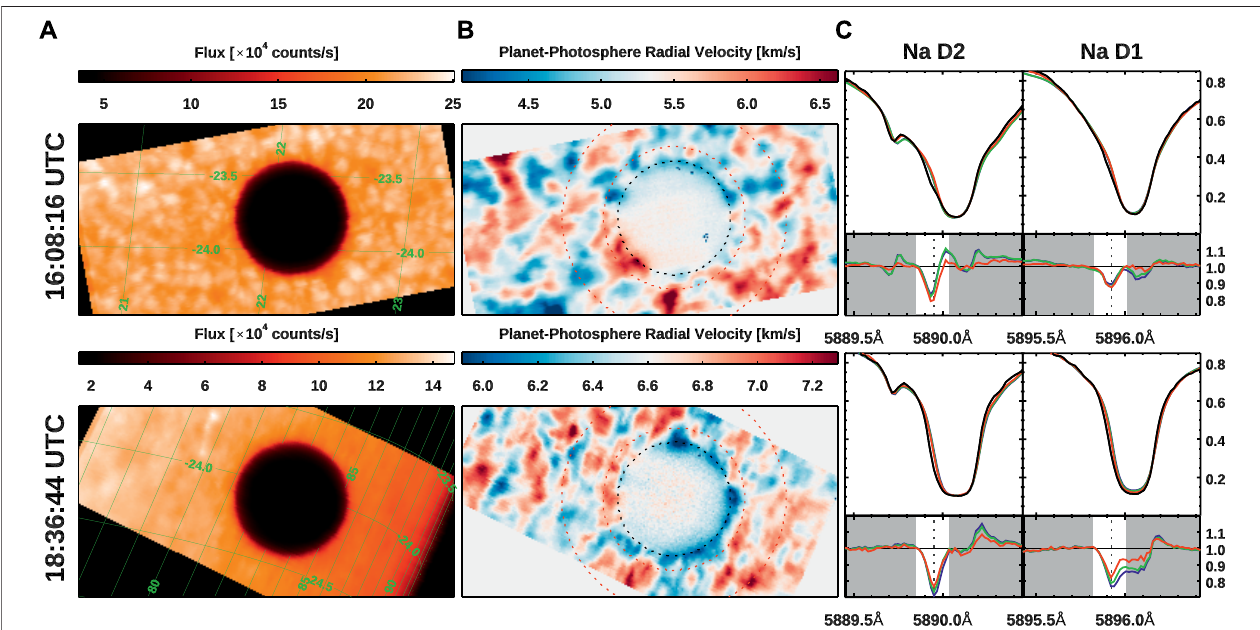
FIGURE1| Intensity,radialvelocity andNaDabsorptionlinepro fi lesduring the2016transitofMercury. (A) showthewavelength-integrated countratesperspatial element, with Carrington heliographic coordinates overlaid. The solar limb is seen at bottom right, just prior to third contact. (B) show the radial velocity between Mercury ’ s rest frame and measured line center of the Fraunhofer D lines. The innermost dashed ring outlines the planet ’ s surface, and the two dashed red lines indicate theannulusappliedinspectralanalysis. (C) showsanexamplespectrum(black)inapixelatMercury ’ sequatorialdawn.Fittedreferencespectraandtheirresiduals are shown in color. Blue is the mean spectrum everywhere beyond the inner annulus ring. Green is the mean spectrum within the annulus bounds (red dotted lines) and co-aligned for Doppler shift. The red reference spectrum uses only the temporal information at this spatial location; it shows the interpolated spectrum at this solar coordinatefromthenearestsixscansintime wherethesolarphotospherewasnotocculted bytheplanet. Onlygrey spectral regionsfarfrom Mercury ’ slineareused for fi tting each reference spectrum, and white regions are used for integrating the exosphere ’ s